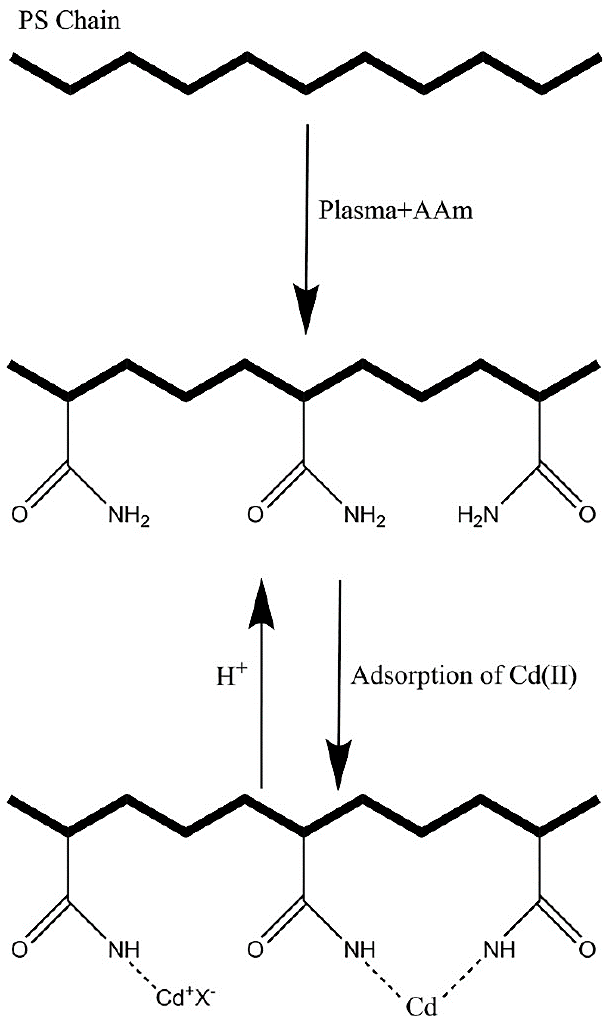
Figure 5. A schematic representation of nanoadsorbent preparation via AAm plasma and HM adsorption [211], With permission from Elsevier, 2016.